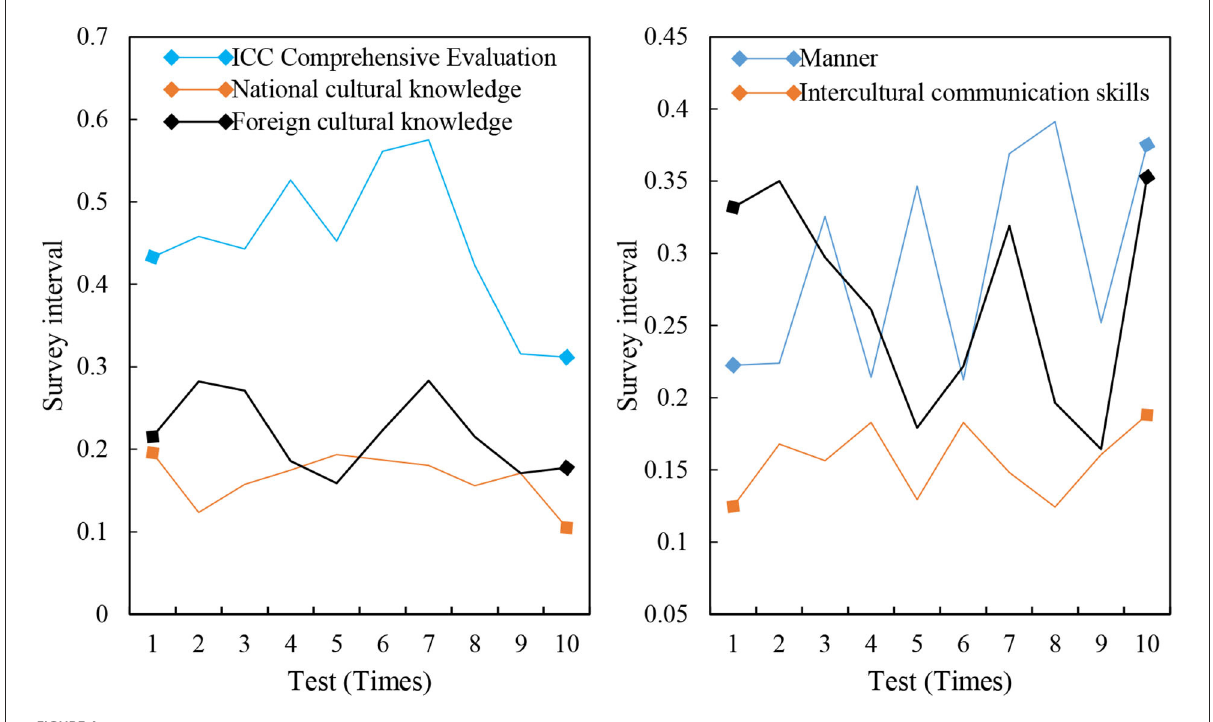
FIGURE4 ICC comprehensive evaluation of 240 people.